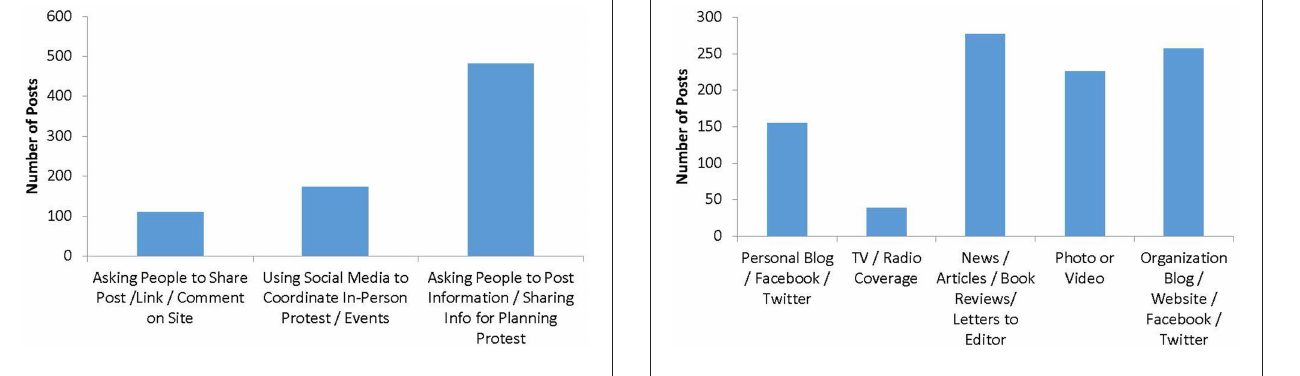
FIGURE 3 | Types of social media protest tactics. FIGURE 4 | Types of links embedded in Facebook